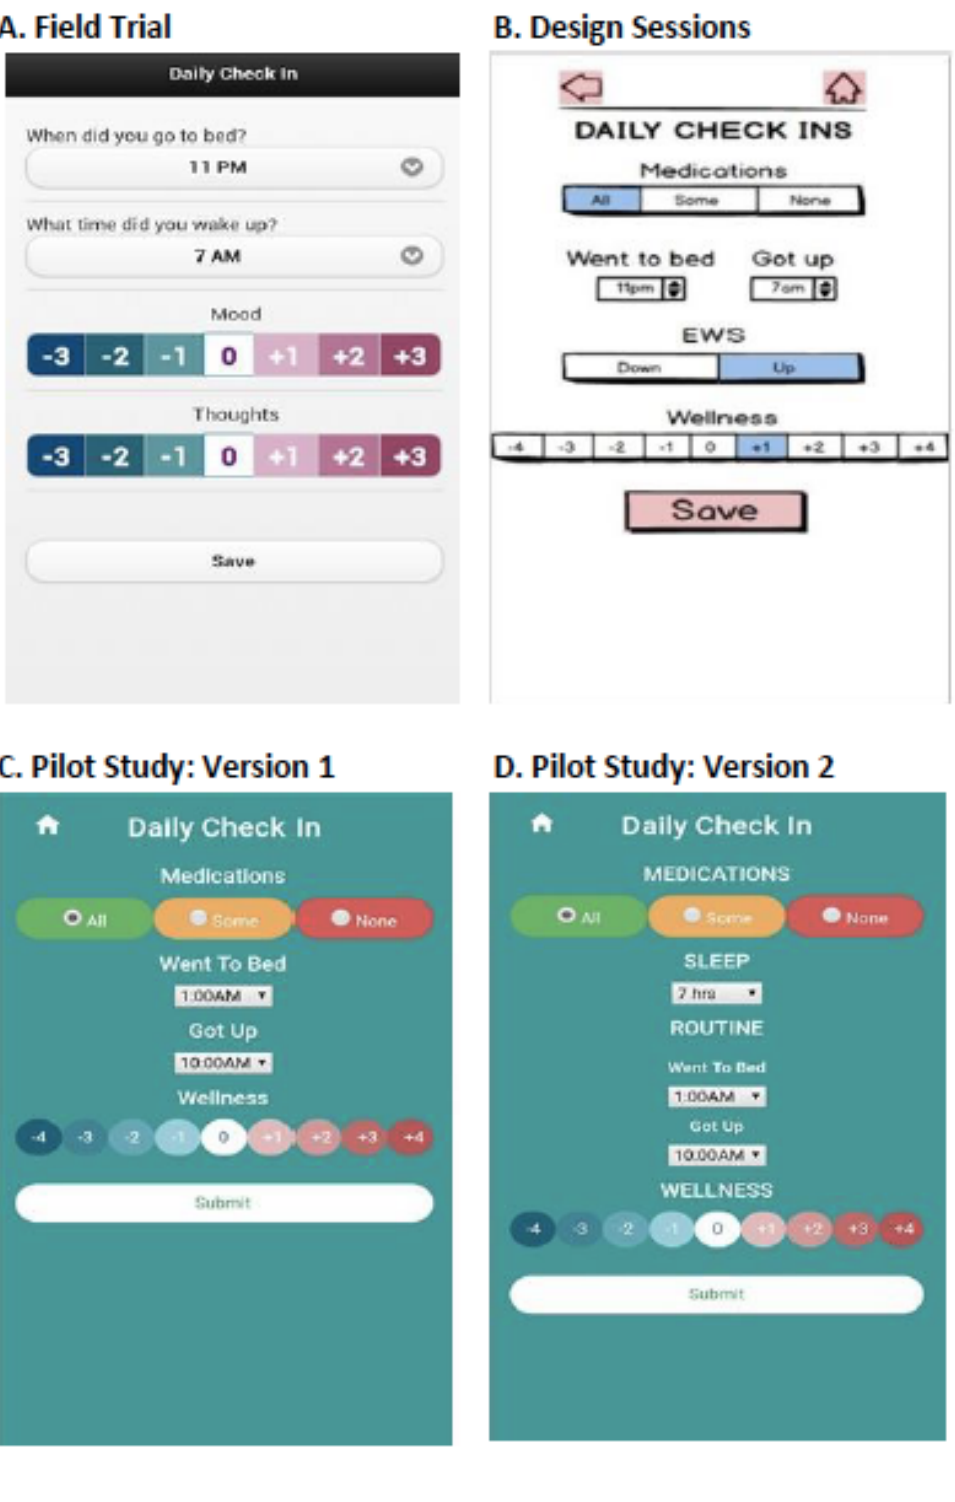
Figure 2. Daily Check-in development. (A) Field trial; (B) Design sessions; (C) Pilot study, version 1; (D) Pilot study, version